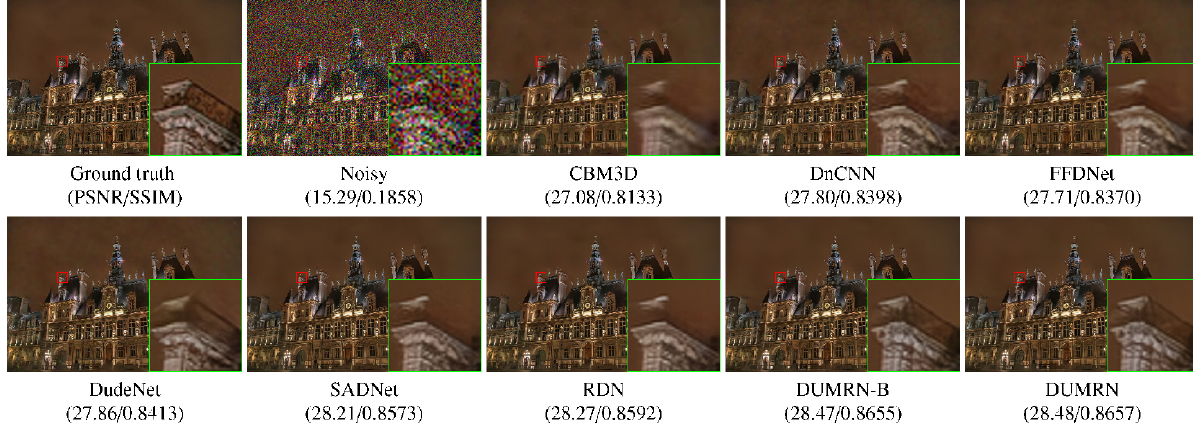
Fig. 6 Color image denoising results on image img 022 from Urban100 with noise level σ =